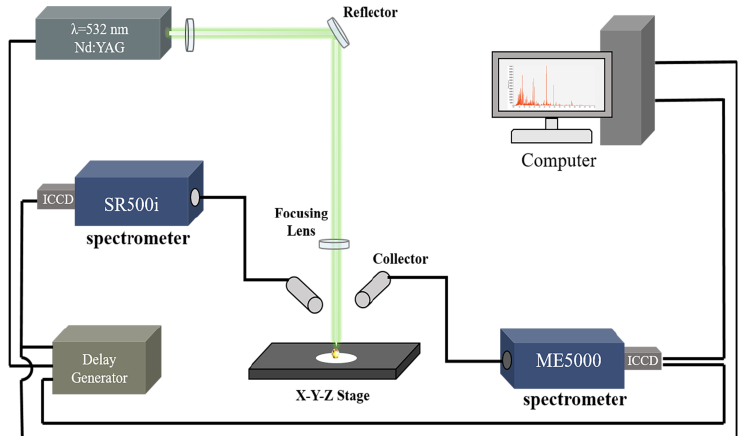
Figure 7. Schematic diagram of the LIBS experimental setup.